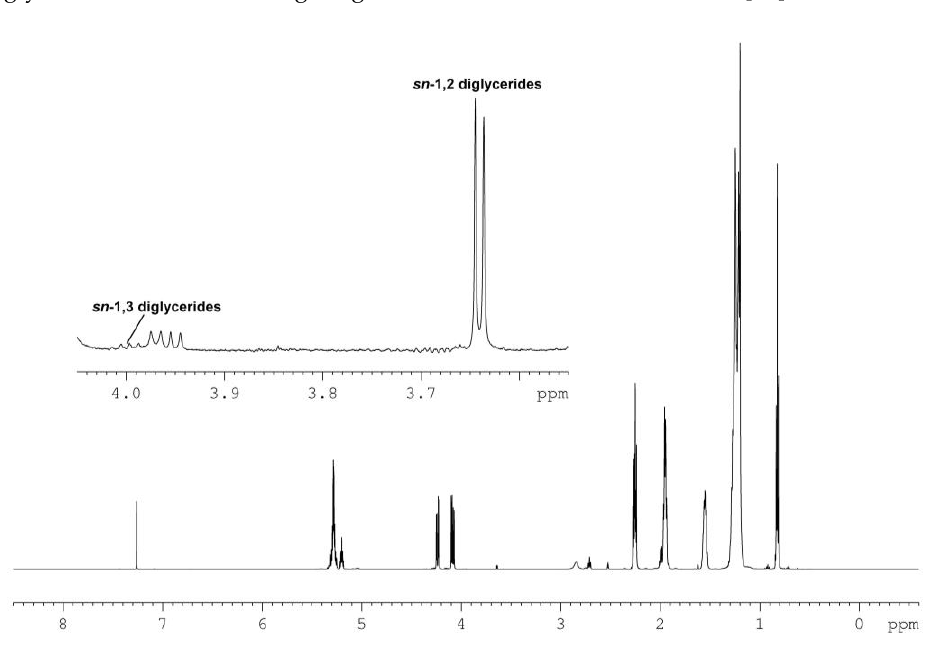
Figure 1. 600.13 MHz 1 H NMR spectrum of an olive oil. An expansion of the 3.5 – 4.0 ppm spectral